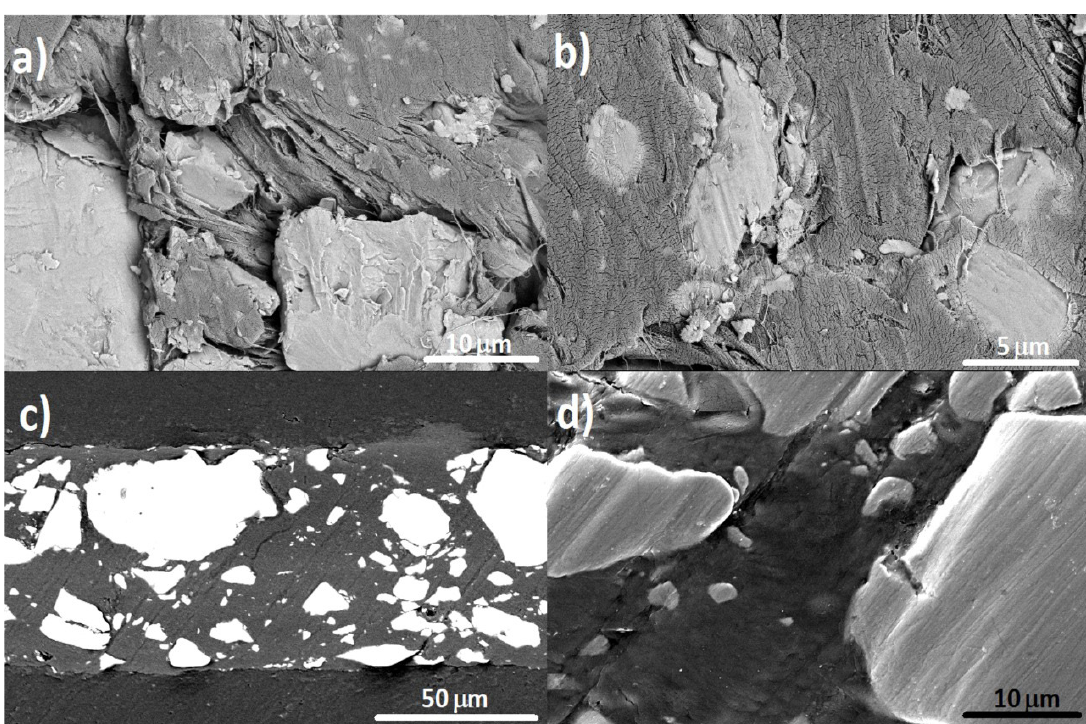
Figure 7. SEM image (BSE mode) of the (a-b) top and (c-d) cross-section of the PTFE-TiFe IMC